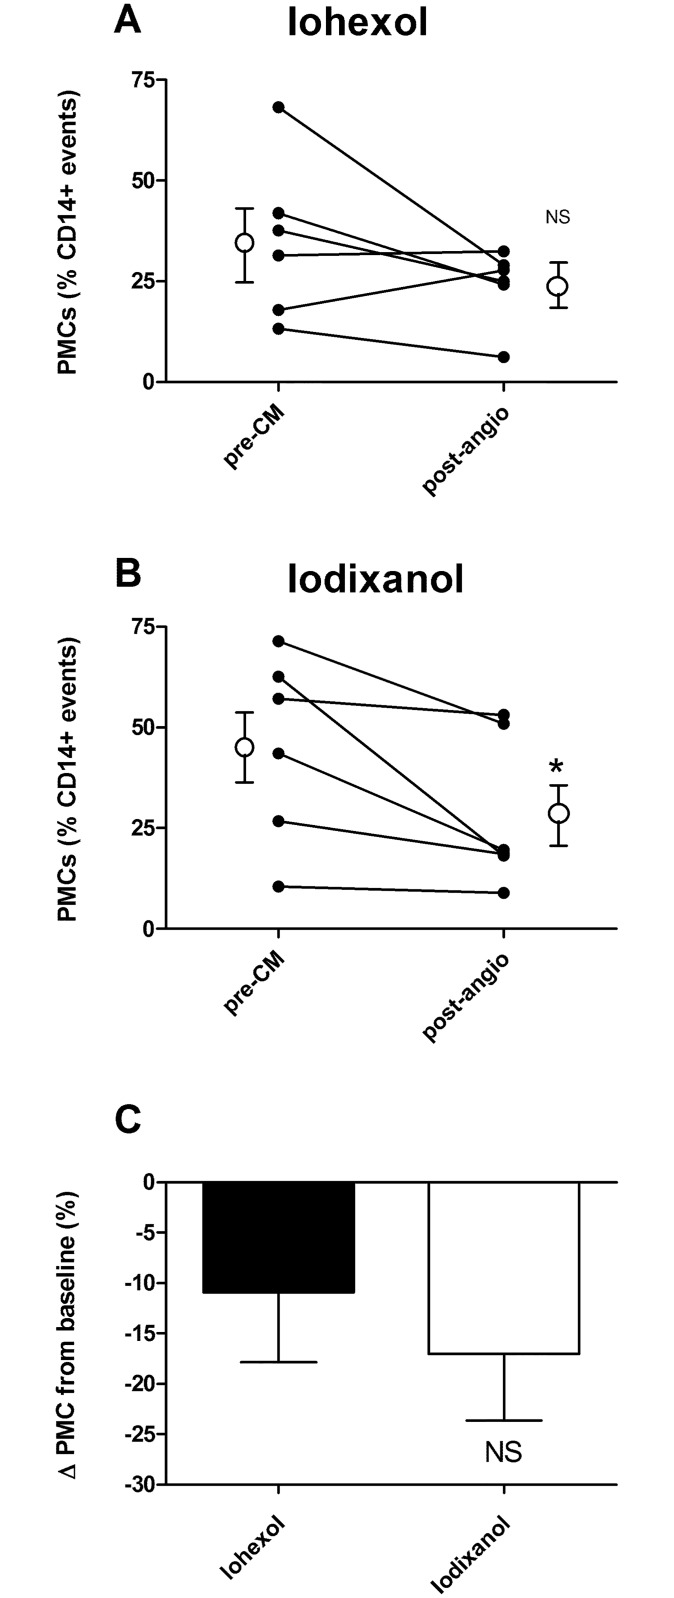
Effect of angiography (post-angio) on platelet-monocyte conjugation in patients exposed to (A) iohexol and (B) iodixanol compared to baseline (pre-CA); *P<0.05. The % reduction in platelet-monocyte conjugation is shown in (C). n = 6 in each group; NS—P>0.05.